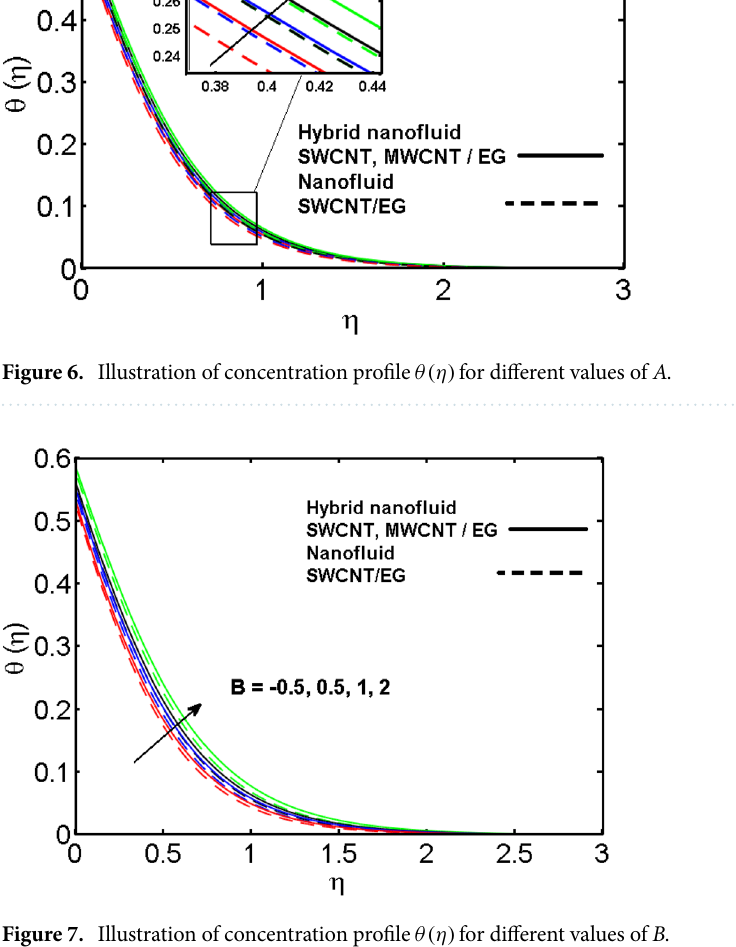
Figure 7. Illustration of concentration profile θ(η) for different values of B